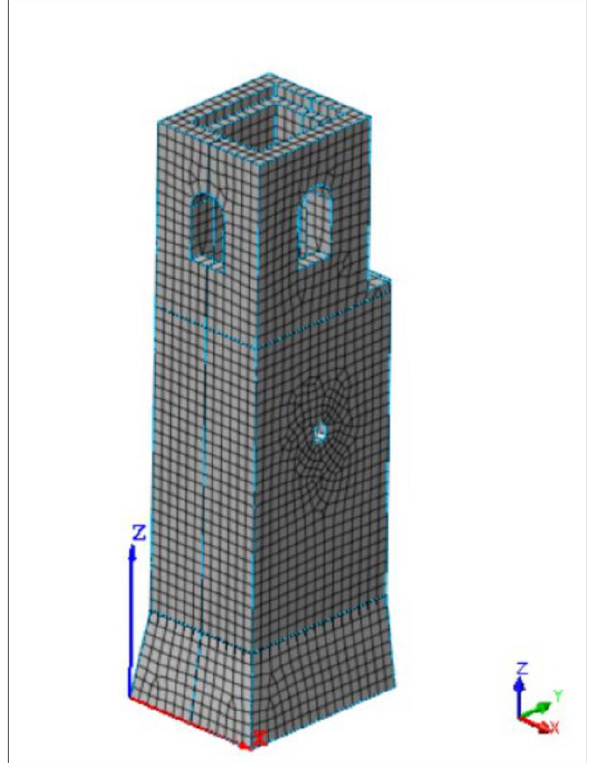
Figure 12. Model of the tower in Midas FEA software. Hybrid hexahedral and tetrahedral, 300 mm average dimension element mesh.